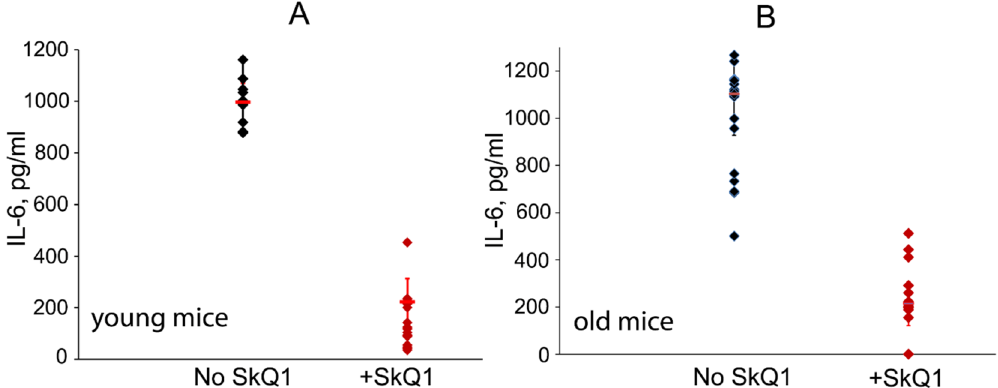
Figure 3. SkQ1 prevents LPS-induced increase in the level of proinflammatory cytokine IL-6. Young ( A ) or old ( B ) mice were injected with LPS (20 mg/kg) and with by SkQ1 (1.5 μmol/kg) as in Fig. 2. The number of mice in each group treated with SkQ1 was 25, and in groups without LPS,